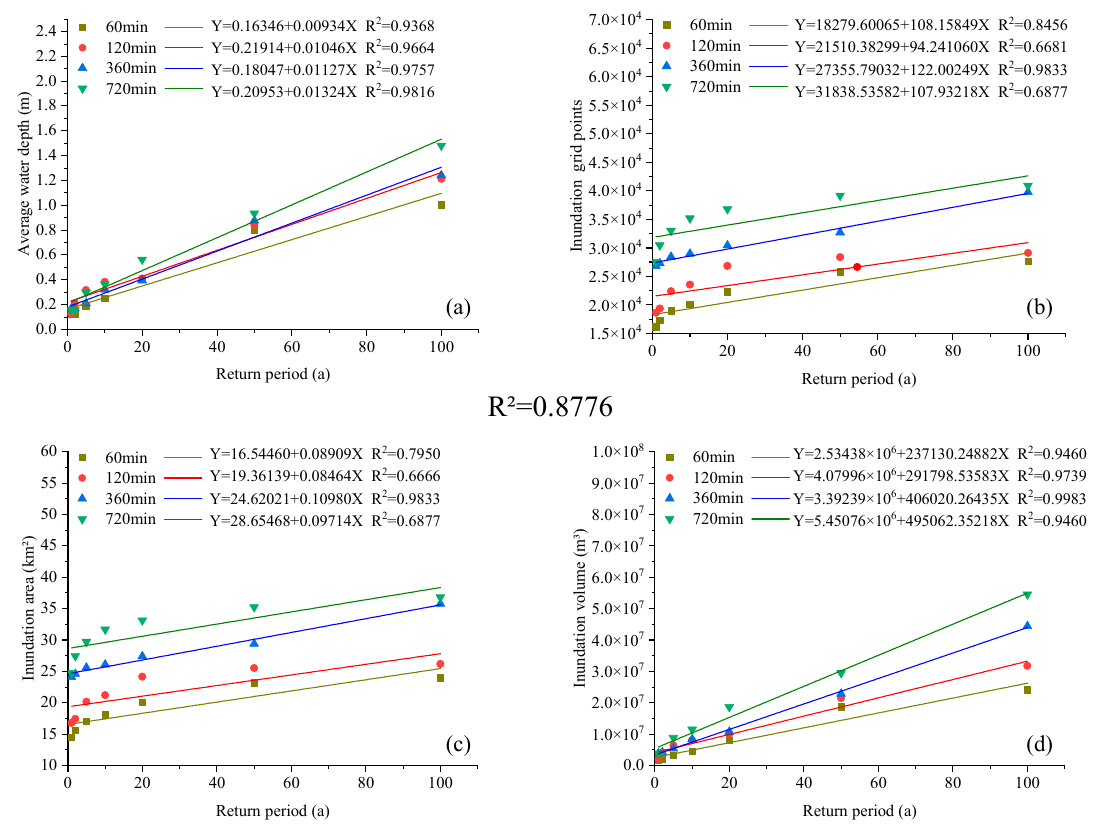
Figure 14. Trend chart of relationship between submerged water depth ( a ), submerged grid points ( b ), submerged area ( c ), submerged water volume ( d ) and return period. (The return period and the four submergence indicators are linearly correlated, with an average R 2 of